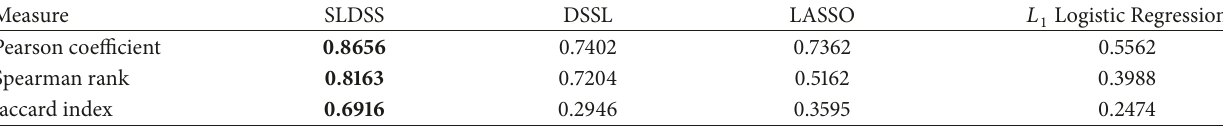
Table 3: Stability of selected feature subsets summarized as an average pairwise similarity over ten training folds.